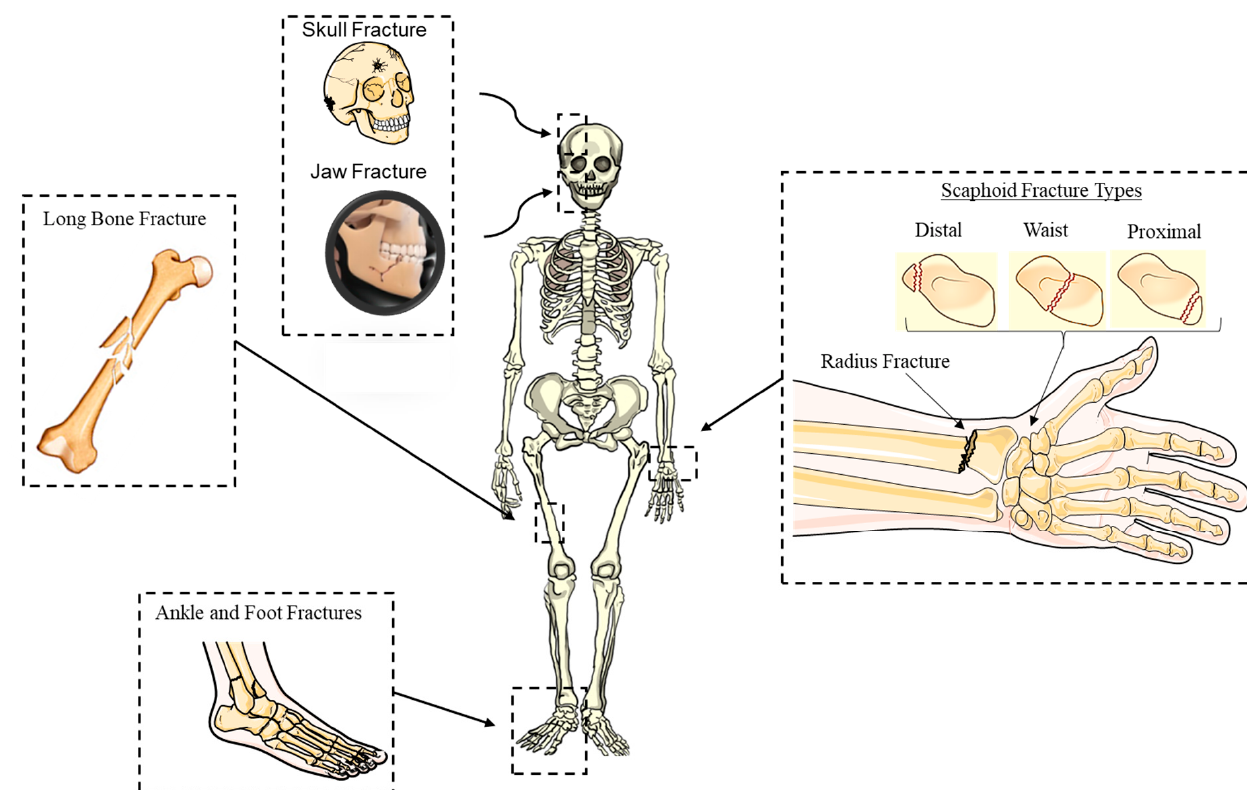
Figure 2. Complex fractures occur most frequently in the long bones, carpal, facial and ankle–foot bones. The wrist, facial and ankle–foot bones contain several small bones close to each other, leading to complex fractures with several bone fragments after a fracture.